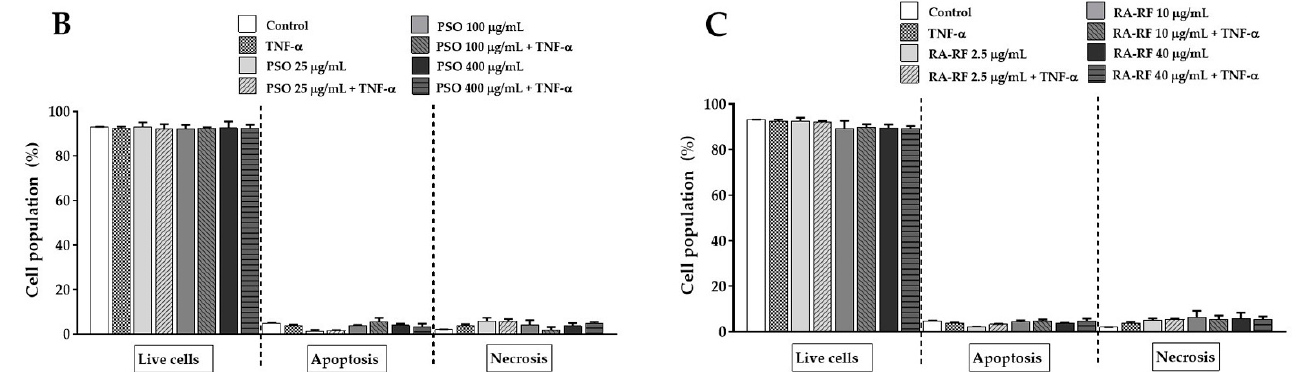
Figure 3. Cell apoptosis and necrosis of A549 cells upon the treatment of PSO (25, 100, and 400 µg/mL) or RA-RF (2.5, 10 and 40 µg/mL), followed by treatment with or without 100 ng/mL TNF- α . Cells were then analyzed using flow cytometry. Dot plots show annexin V-FITC+/PI- as early apoptotic cells, annexin V-FITC+/PI+ as late apoptotic cells, and annexin V-FITC-/PI+ as necrotic cells ( A ). Live, apoptotic, and necrotic cells were presented as a percentage of cell population in the bar graphs of PSO ( B ) and RA-RF ( C ). The data were reported as a mean ± SD of three independent experiments carried out in triplicate.